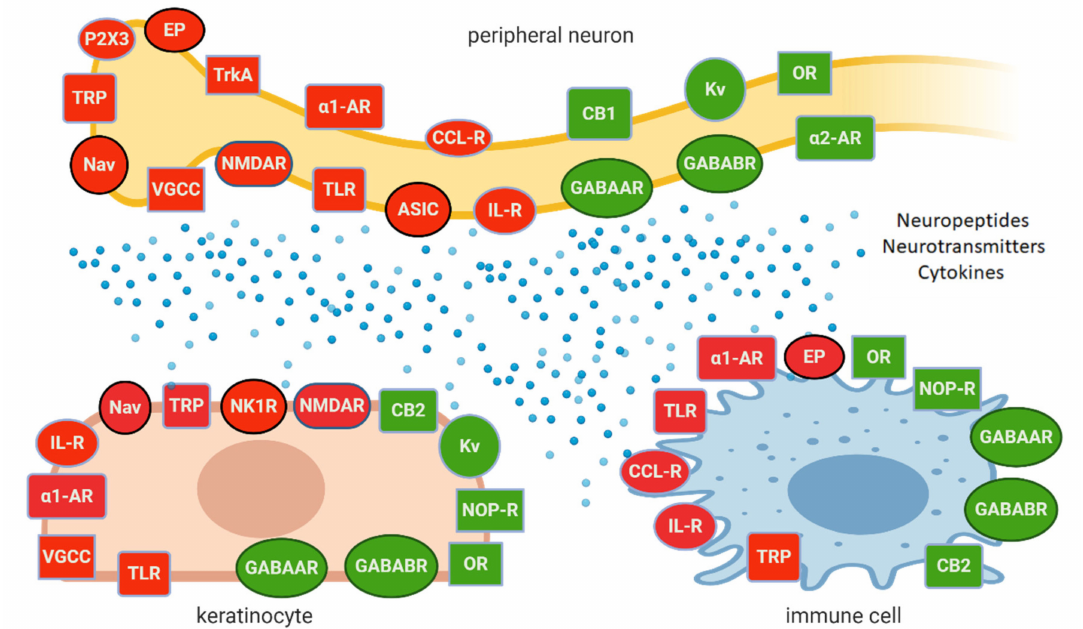
Figure 2. Complex interplay of peripheral neurons, keratinocytes, and immune cells; expressing excitatory (in red) or inhibitory (in green) ion channels or receptors, involved in pain generation, modulation, and maintenance, which potentially may be a target for topical treatments. Abbreviations: Nav—voltage-gated sodium channel, TRP—transient receptor potential channel, VGCC—voltage-gated calcium channel, NMDAR—N-methyl-D-aspartate receptor, ASIC—acid-sensing ion channel, TLR—toll-like receptor, α 1-AR- α 1 adreno receptor, α 2-AR— α 2 adreno receptor, EP—prostaglandin E2 receptor, GABAAR—gamma-aminobutyric acid receptor A, GABABR—gamma-aminobutyric acid receptor B, Kv—voltage-gated potassium channel, OR—opioid receptor, CB1, CB2—cannabinoid receptor type 1 or 2, NOP-R—nociceptin receptor, CCL- R—chemokine receptor, IL-R—interleukin receptor, TrkA—Tropomyosin receptor kinase A, NK1R—neurokinin 1 receptor. Created with BioRender.com